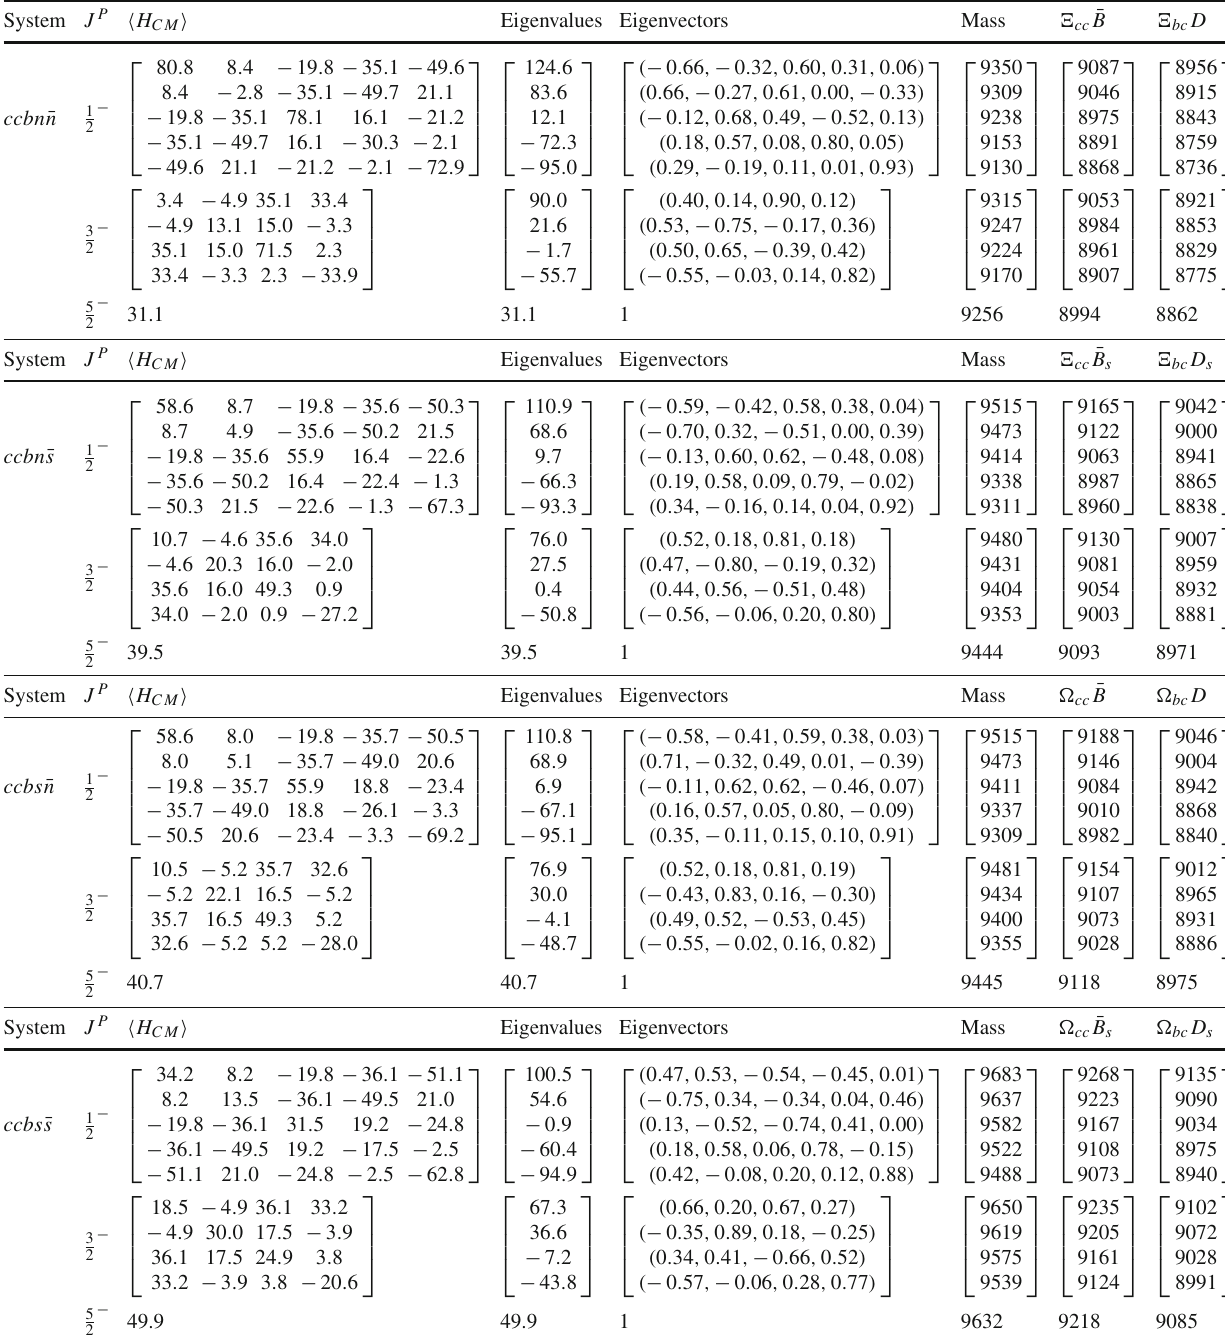
Table 7 Numerical results for the ccbq ¯ q systems in units of MeV. The masses in the sixth column are estimated with Eq. (18) and those in the last two columns with the ( ccq ) - ( b ¯ q ) type and ( bcq ) - ( c ¯ q ) type thresholds, respectively System J P (cid:8) H CM